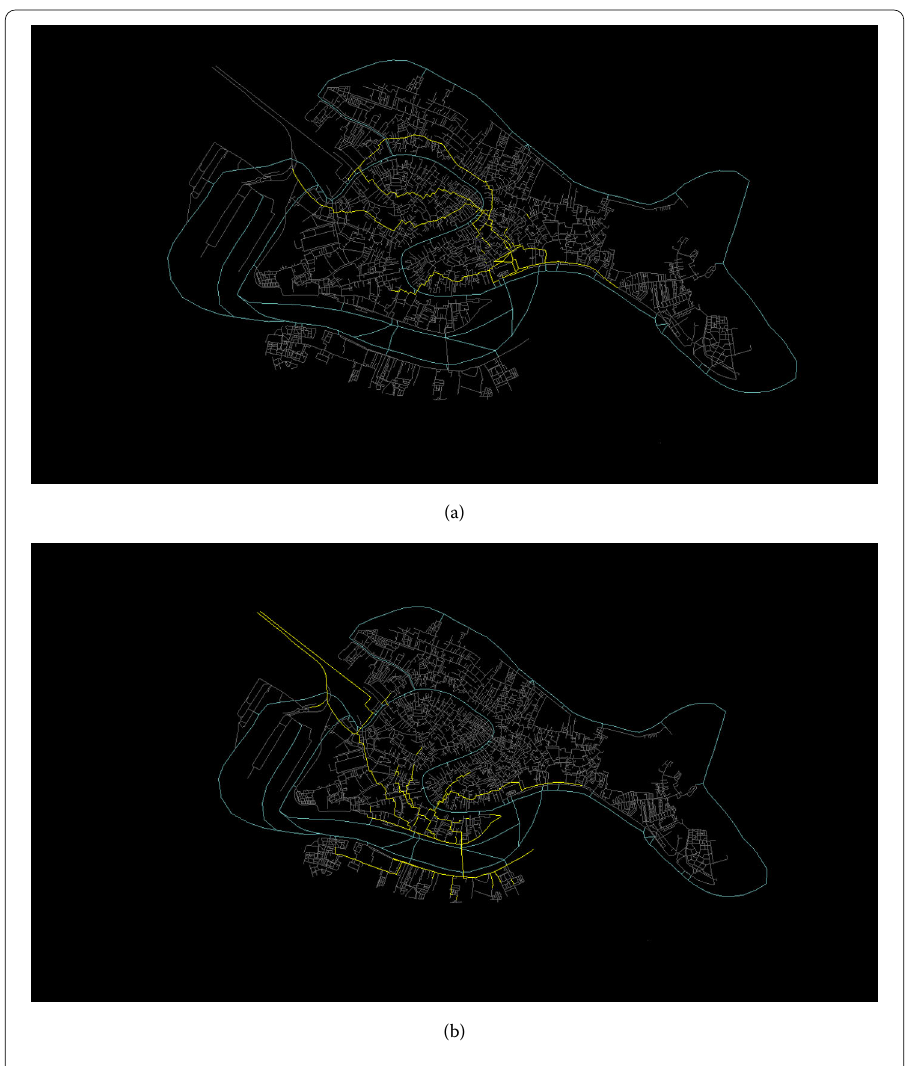
Figure 10 Picture (a): the mobility network driven by the attractiveness of San Marco square during 26/02/2017 that takes into account the 61% of the total pedestrian mobility towards the square. Picture (b): the mobility network driven by the attractiveness of Giudecca island during 15/07/2017 that takes into account the 54% of the total pedestrian mobility towards the